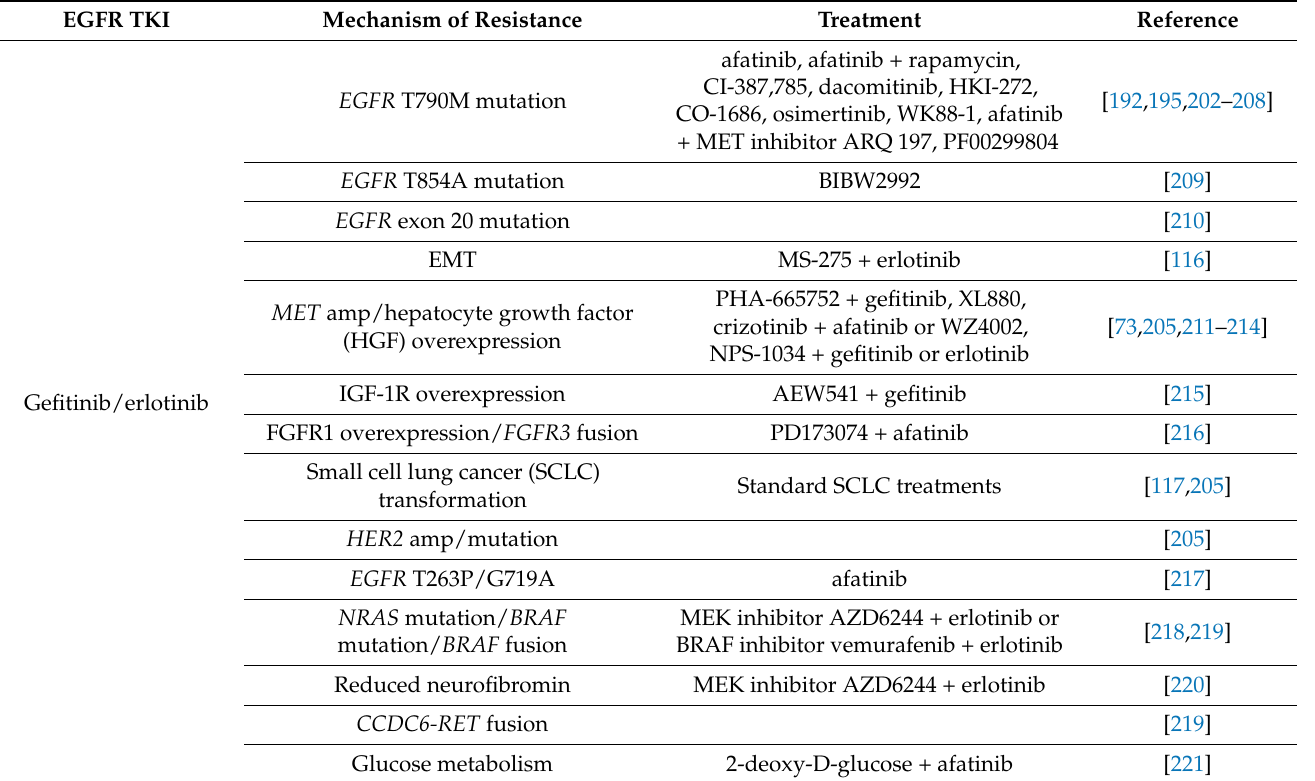
Table 1. Mechanisms of resistance to EGFR TKIs independent of TAM kinases. EGFR TKI Mechanism of Resistance Treatment Reference